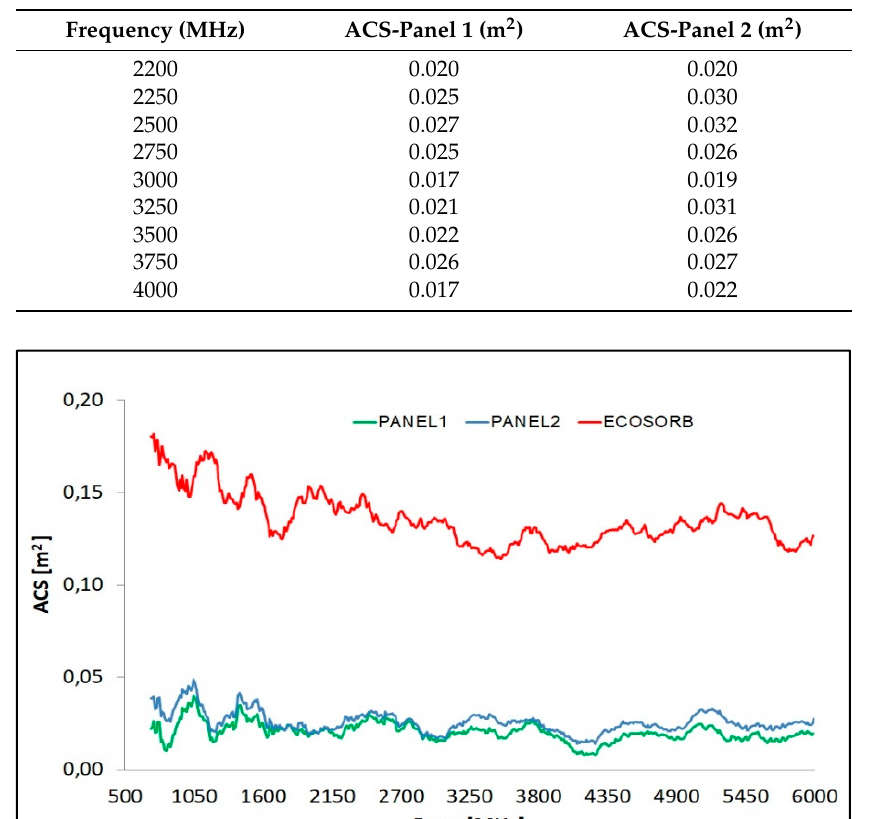
Table 5. Absorbing cross section (ACS) values of the multilayered panel in the S-band.